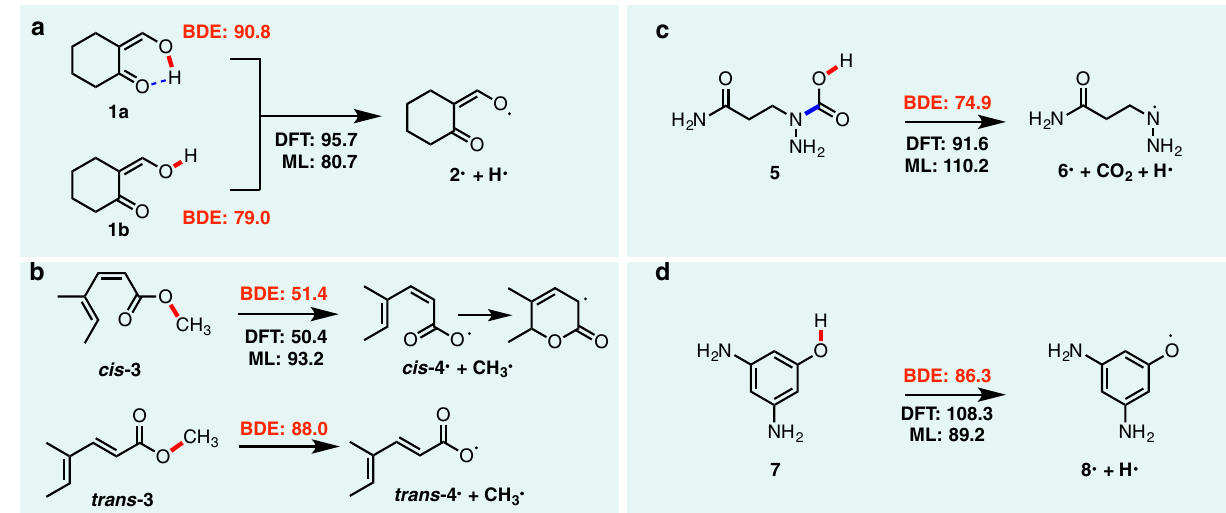
Fig. 4 Error analysis of predicted and DFT-calculated BDE values. Ground-truth G4 values (in kcal mol − 1 ) for representative molecules with large prediction errors are shown in red.